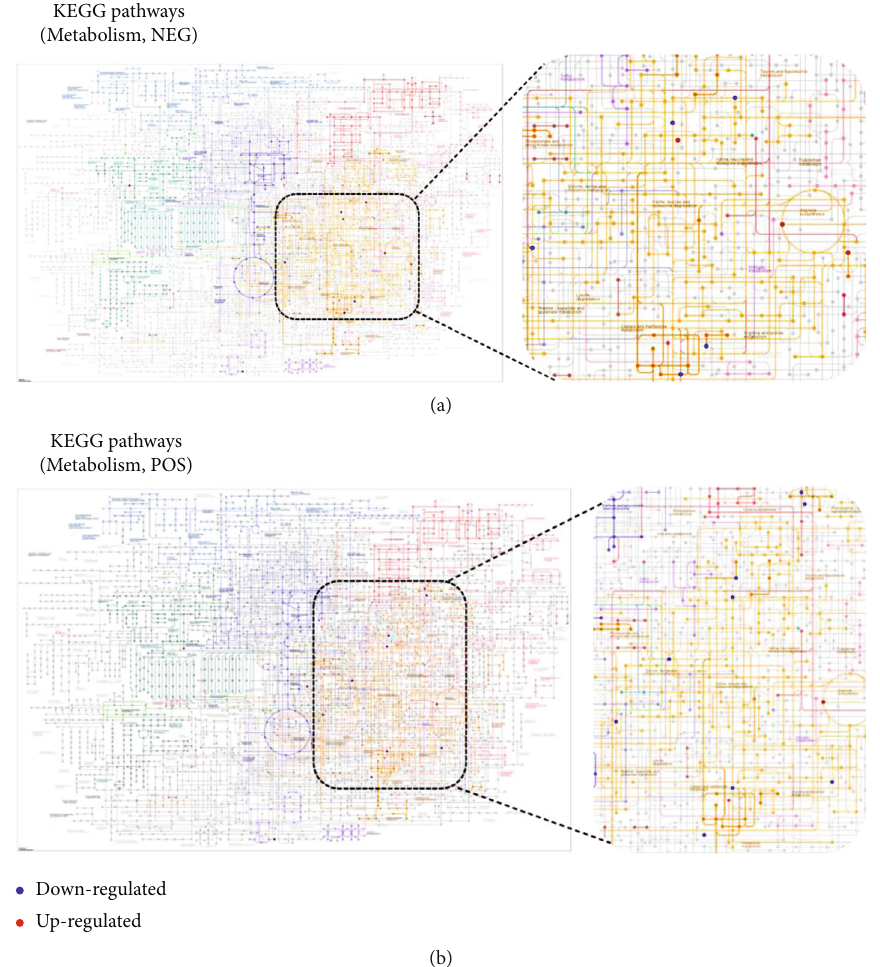
Figure 3: KEGG pathway classi fi cation: metabolites detected and annotated; red/blue dots represent the di ff erentially expressed compounds; color depth represents the P